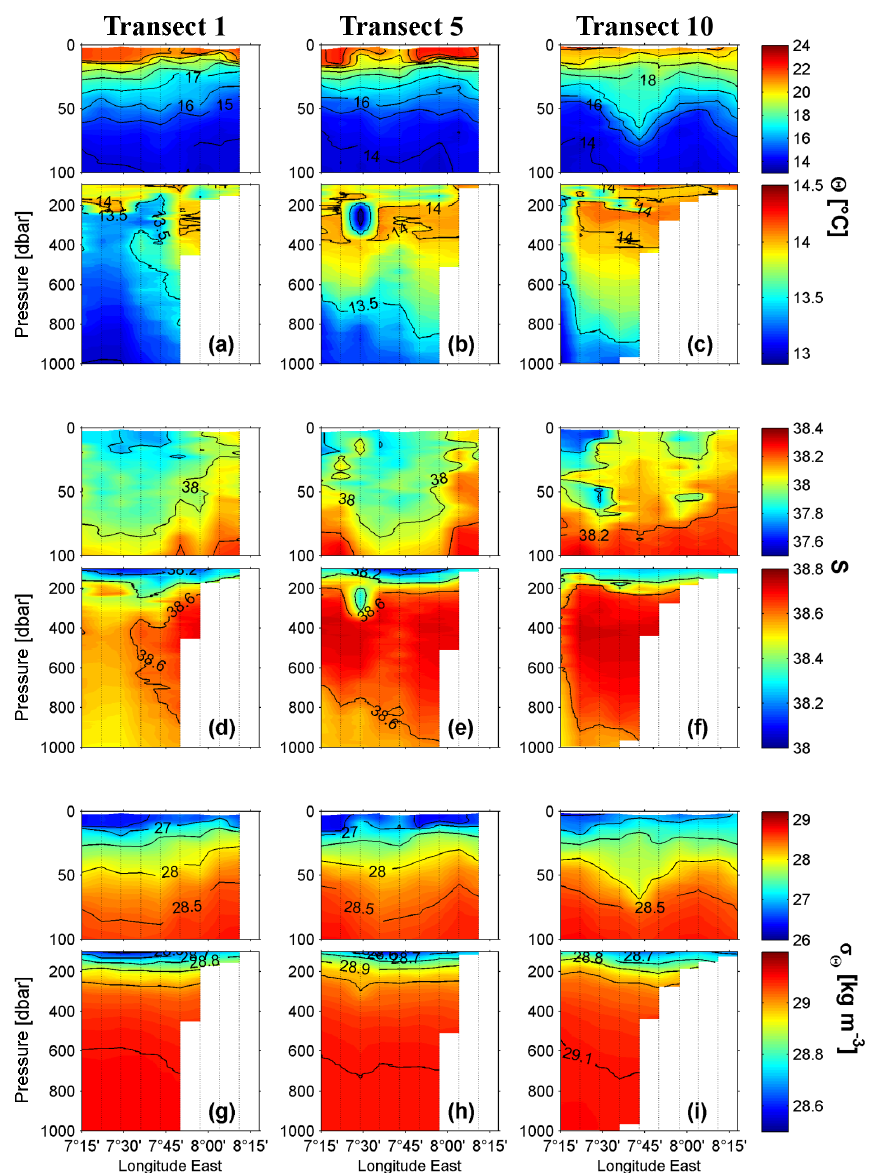
Figure 5. Potential temperature ( (cid:50)) , salinity ( S ), and potential density anomaly ( σ (cid:50) ) along the zonal (a, d, g) transect 1 (40 ◦ 12 (cid:48) N), (b, e, h) transect 5 (39 ◦ 48 (cid:48) N), and (c, f, i) transect 10 (39 ◦ 18 (cid:48) N) in the upper 100 and 1000dbar based on Planet CTD casts (dotted lines) given in Fig.